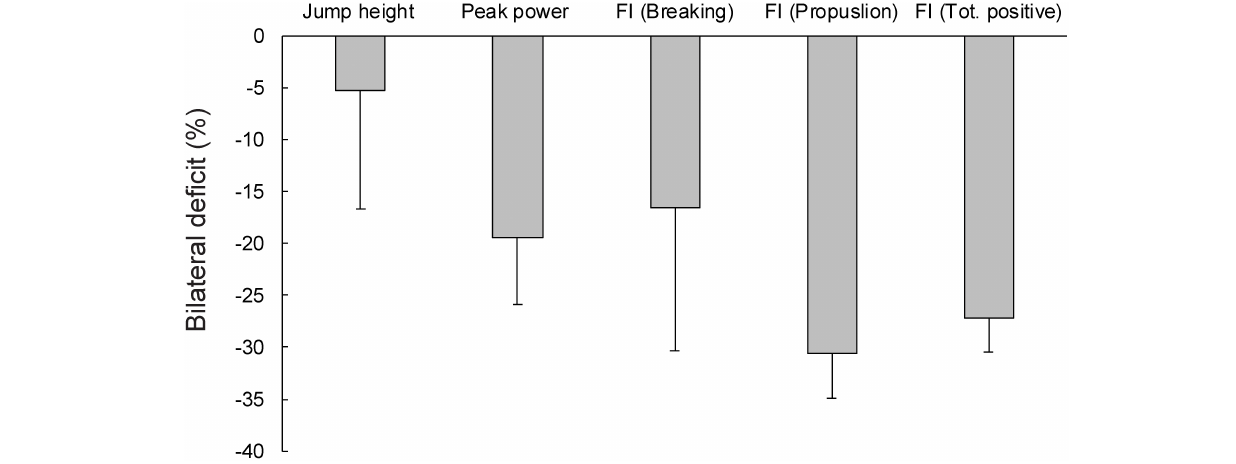
FIGURE 1 | The bilateral deficit in countermovement jump variables. FI, force